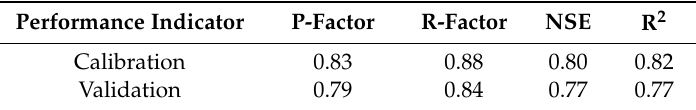
Table 4. Calibration Results for SWAT